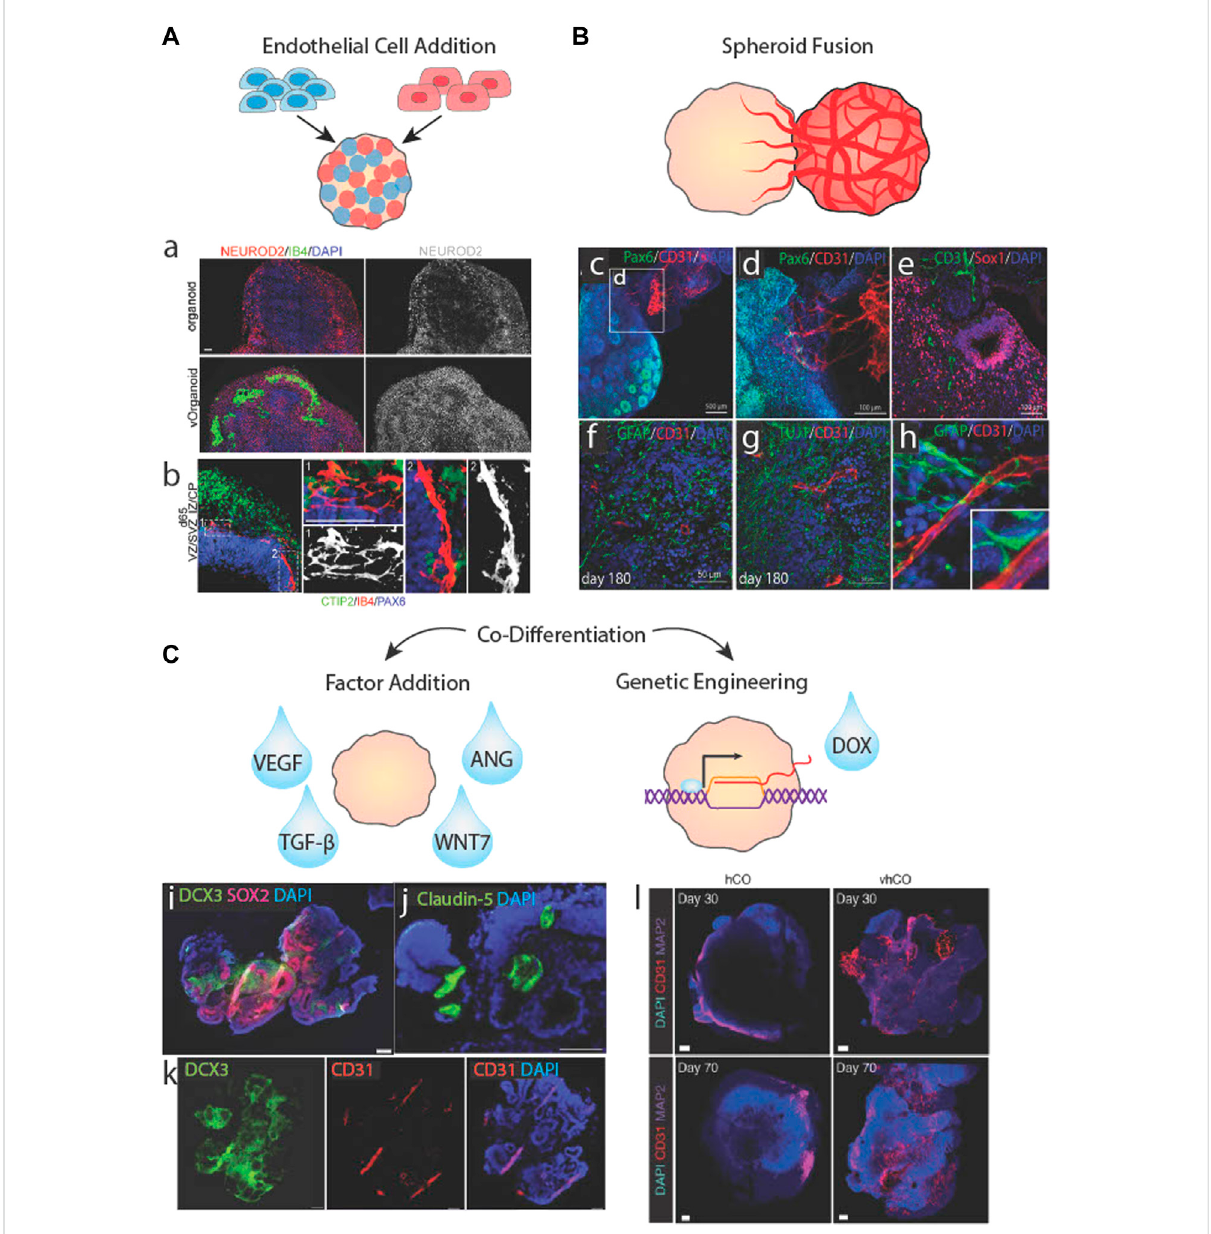
FIGURE 3 Biological approaches to brain organoid vascularization. (A) Schematic of organoid vascularization by mixing pluripotent stem cells with endothelail cells. a.b. Vascularized brain organoids generated by mixing HUVECs with stem cells showing localized clusters of vessel-like structures and vascular cells interacting with neurites. Adapted from (Shi et al., 2020). (B) Schematic of a brain organoid fused to a vascular spheroid. c.d.e. Vessels from a vascular spheroid invading the neuroepithelium of a brain organoid. f.g.h. Vessels from a vascular spheroid interacting with neurons and astrocytes/radial glia. Adapted from (Wörsdörfer et al., 2019). (C) Schematic of brain organoid vascularization by the addition of soluble factors or genetic engineering of inducible transcription factor systems. i.j.k Co-differentiated vascularized brain organoid stained for neural cell, vasucular cell, and tight junction markers. Adapted from Ham et al. (2020). Vascular markers in control (hCO) versus vascularized cortical organoids (vhCO), which carry an inducible Ets variant transcription factor 2 ( ETV2 ) genetic system. Adapted from (Cakir et al.,